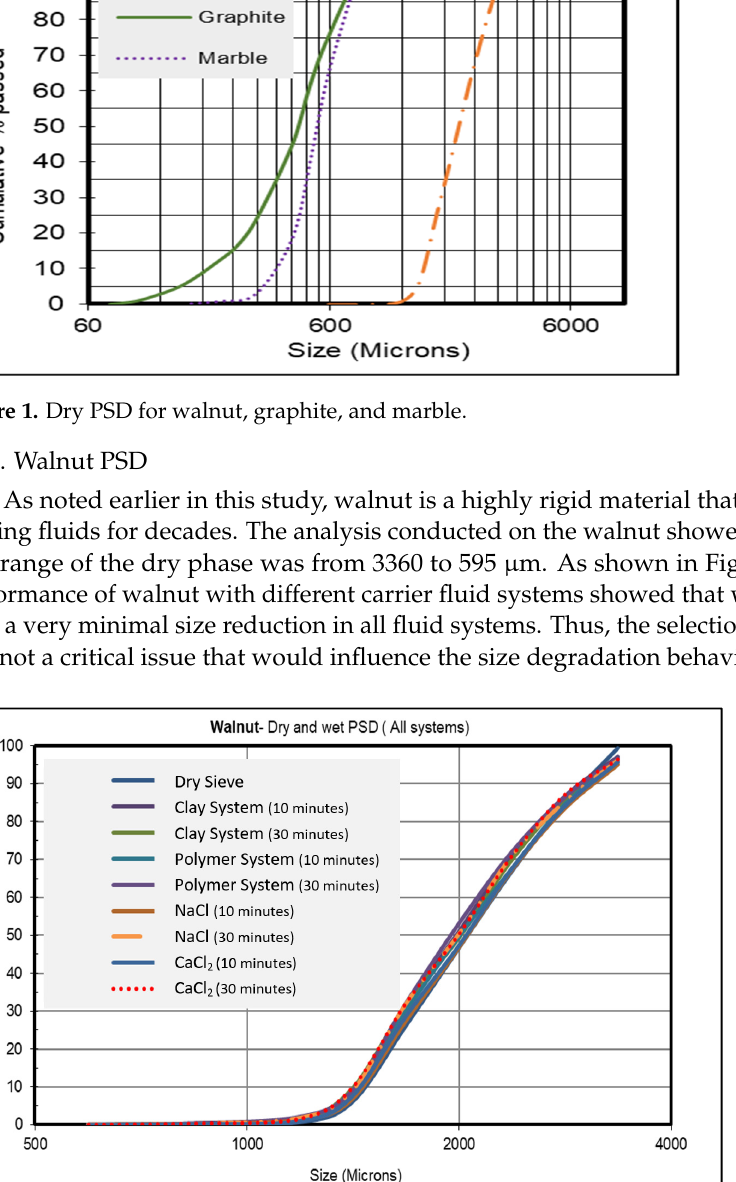
Table 4. Dry cumulative distributions values for all granular materials. Material